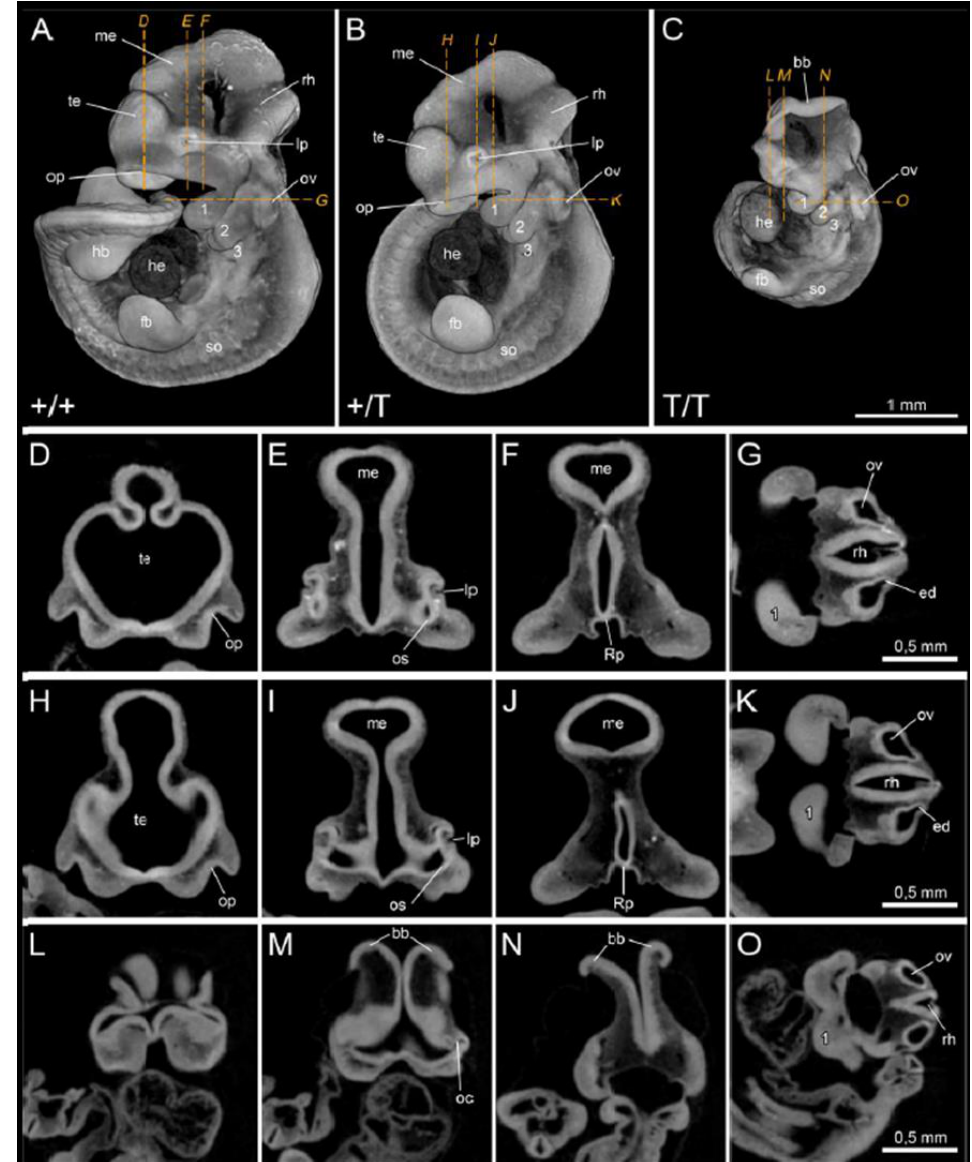
Figure 3. µCT analysis of E10.5 embryos. Volume renderings show lateral view of ( A ) wild type (+/+; n = 4), ( B ) heterozygous (+/T; n = 4), and ( C ) homozygous (T/T; n = 3) embryos. Virtual µCT sections of ( D, E, F, G ) wild type, ( H, I, J, K ) heterozygous, and ( L, M, N, O ) homozygous embryos. Note that in (A) the tail bud was clipped unintentionally during specimen preparation and in (B) the hindlimb bud and tail bud are located behind the embryo head and thus are hidden in the image. (1, 2, 3: branchial bars 1 – 3; bb: brain bulges; ed: endolymphatic duct; fb: forelimb bud; hb: hindlimb bud; he: heart; lp: lens pit; me: mesencephalon; oc: optical cup; op: olfactory pit; os: optic stalk; ov: otic